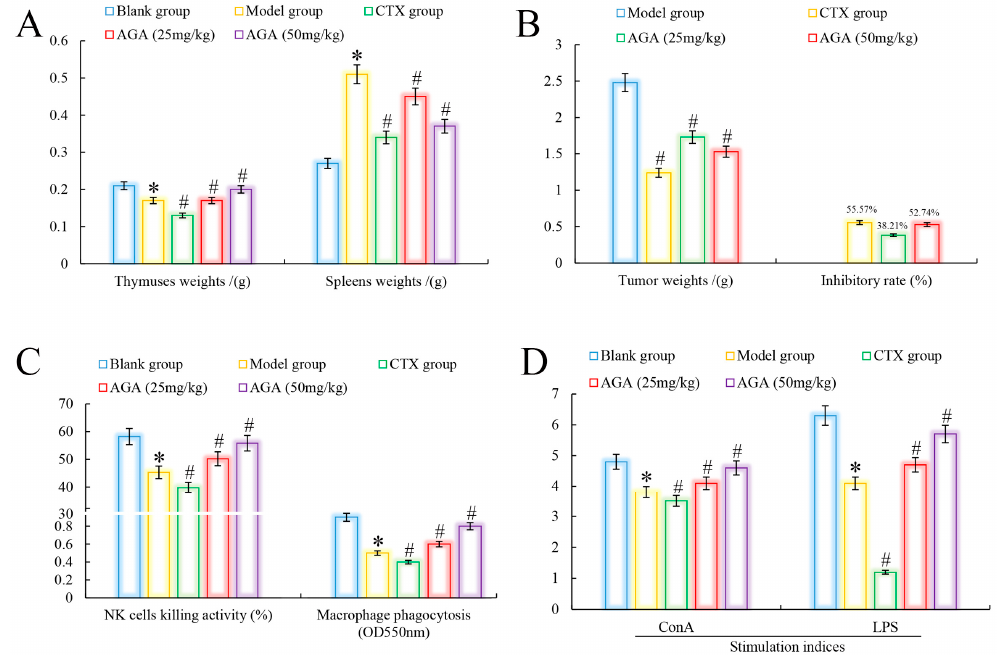
Figure 2. Antitumor effects of AGA in vivo. Immune organ indices ( A ) and tumor inhibitory rate ( B ). NK cell killing activity, macrophage pinocytosis ( C ), and splenic lymphocyte proliferation activities ( D ). * p < 0.05, compared with Blank group; # p < 0.05, compared with Model